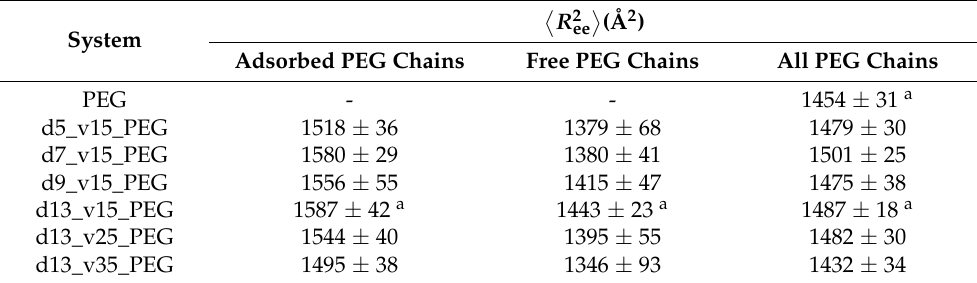
Table 5. MD predictions for the the text, for the nanocomposites, we also report the separate chains. a Data obtained from ref.